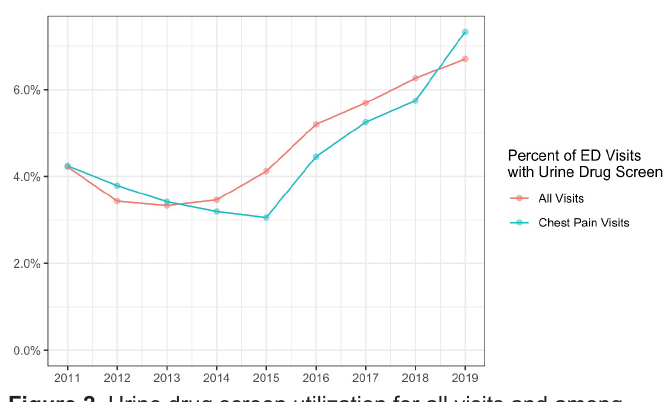
Figure 2. Urine drug screen utilization for all visits and among visits for chest pain by year.